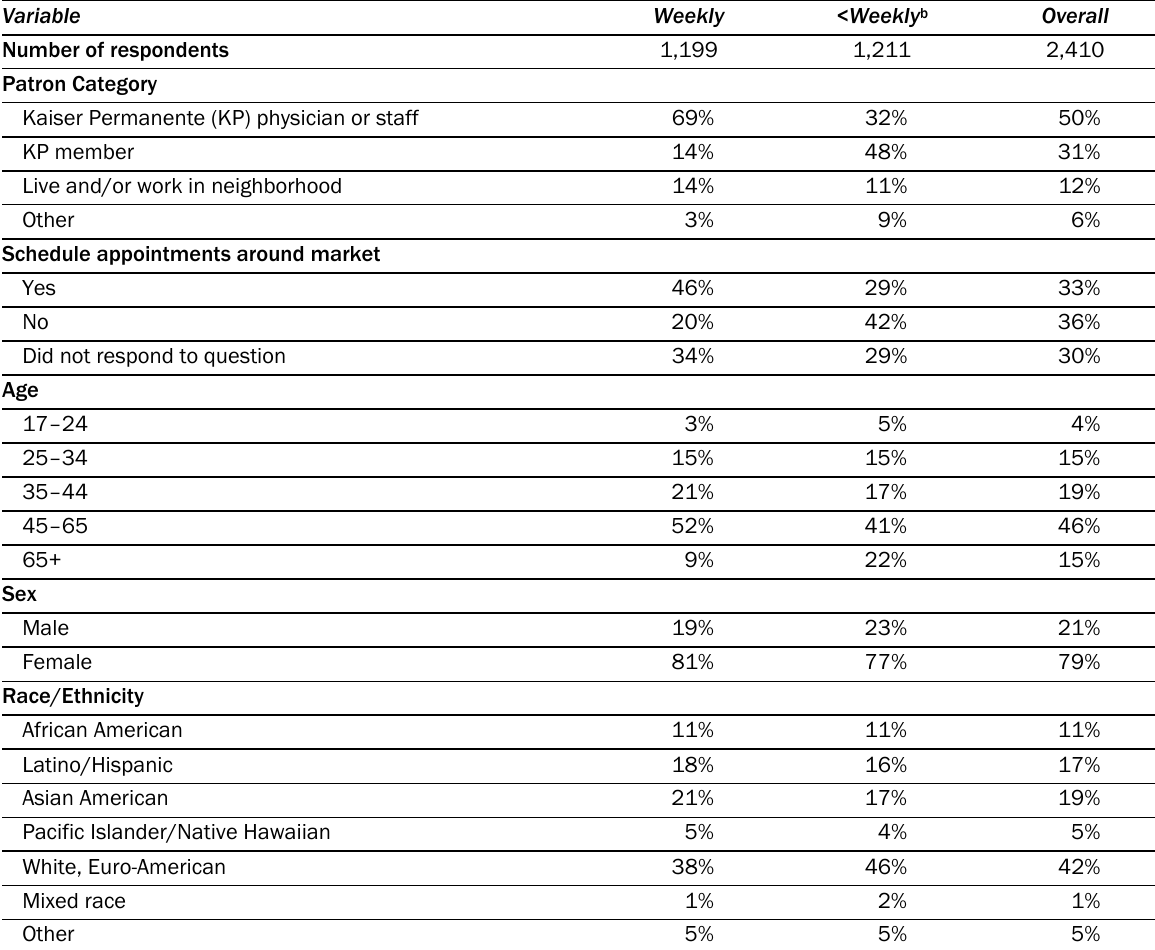
Table 1. Kaiser Permanente Farmers’ Market Survey: Respondent Characteristics by Frequency of Market Use